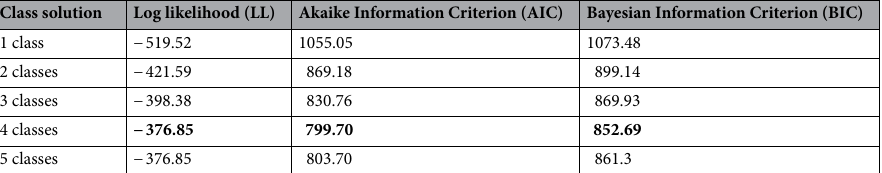
Table 2. Incremental fit statistics and log likelihood for best class solution, latent class analysis, Psychiatric Children’s Hospital, Mexico City, Mexico, 2017–2019 (n = 74). Bold values indicate the 4 class solution was the best fitting model.